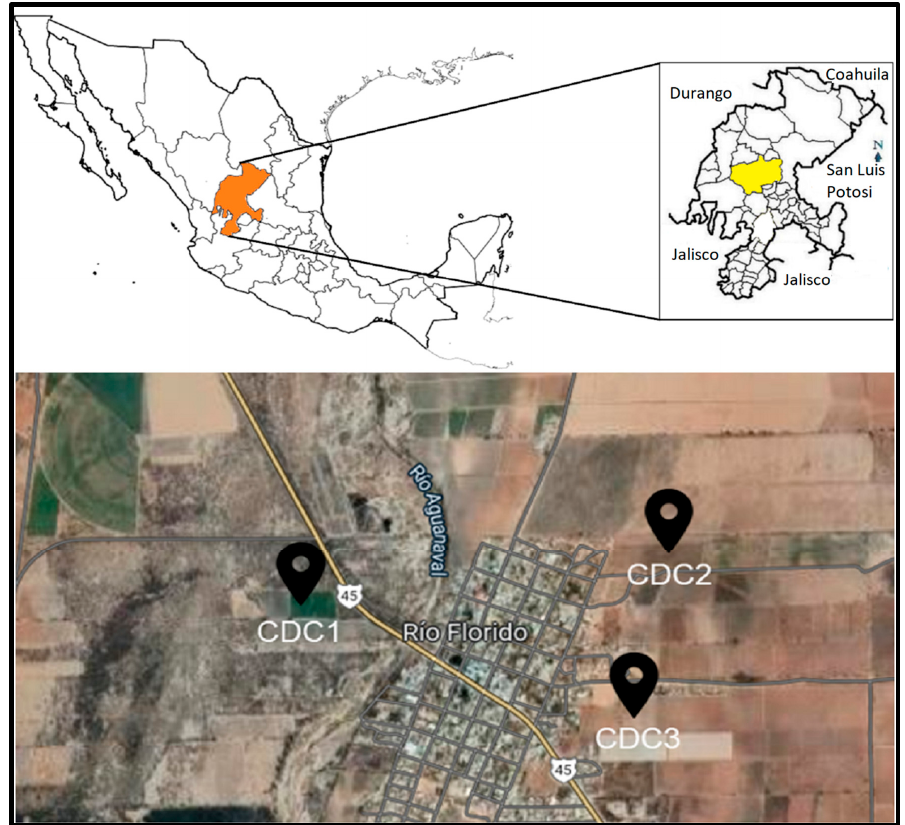
Figure 1. Map of the region from where the samples of Croton dioicus were taken: Río Florido. The samples’ coordinates are CDC 1 (23°20 ′ 53.06 ″ N, 102°59 ′ 53.79 ″ O); CDC 2 (23.349884,102°59 ′ 1.87 ″ O); CDC 3 (23 ◦ 20 (cid:48) 36.60 (cid:48)(cid:48) N, 102 ◦ 59 (cid:48) 5.89 (cid:48)(cid:48)